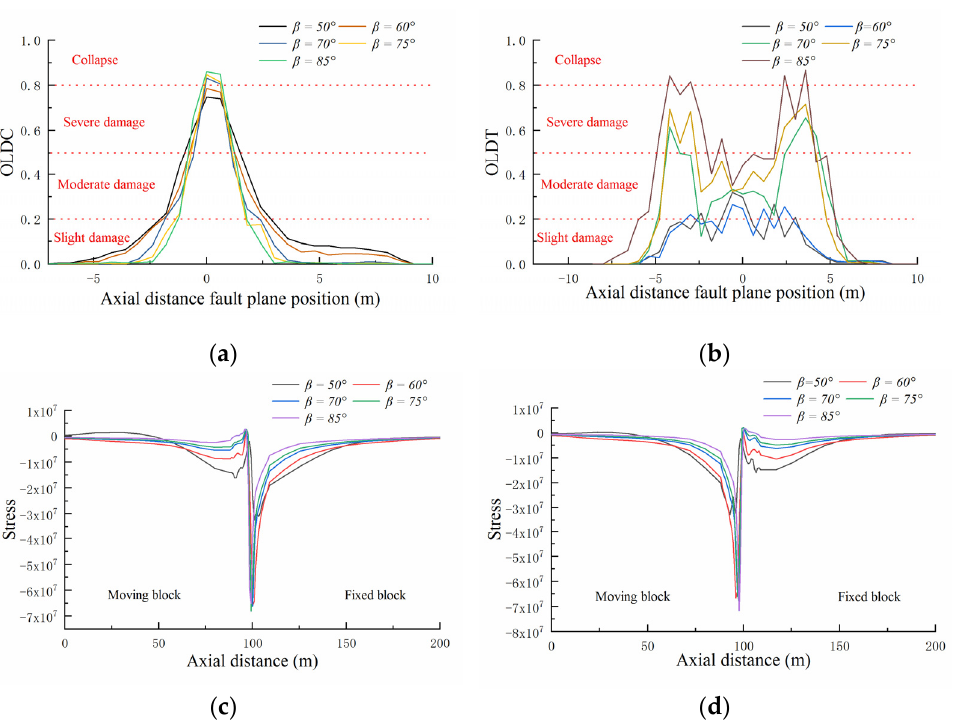
Figure 10. Overall concrete lining damage under different fault dip angles ( Δ f = 8 cm; stiff) and axial stress curve of concrete vault and invert ( a ) OLDC, ( b ) OLDT, ( c ) vault and ( d ) invert.